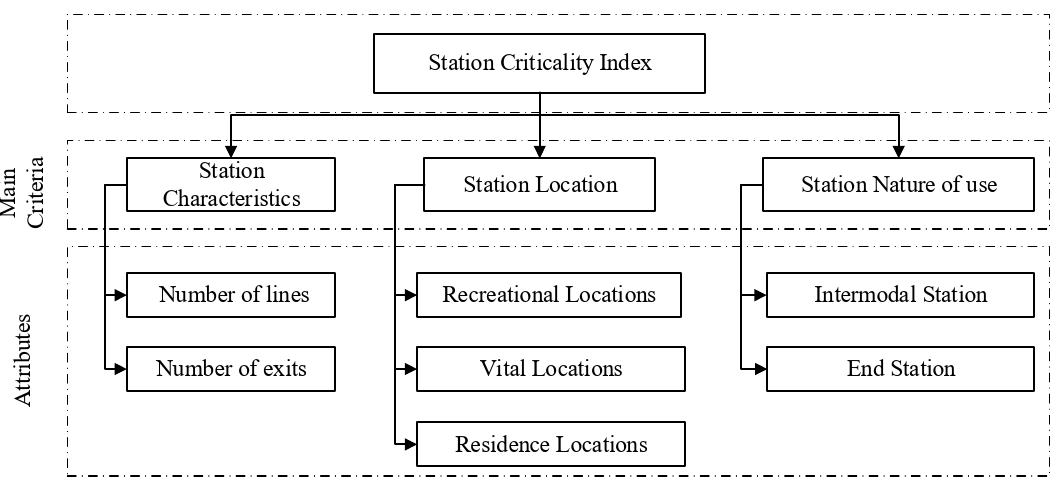
Figure 6. Criticality Module Attributes [25].